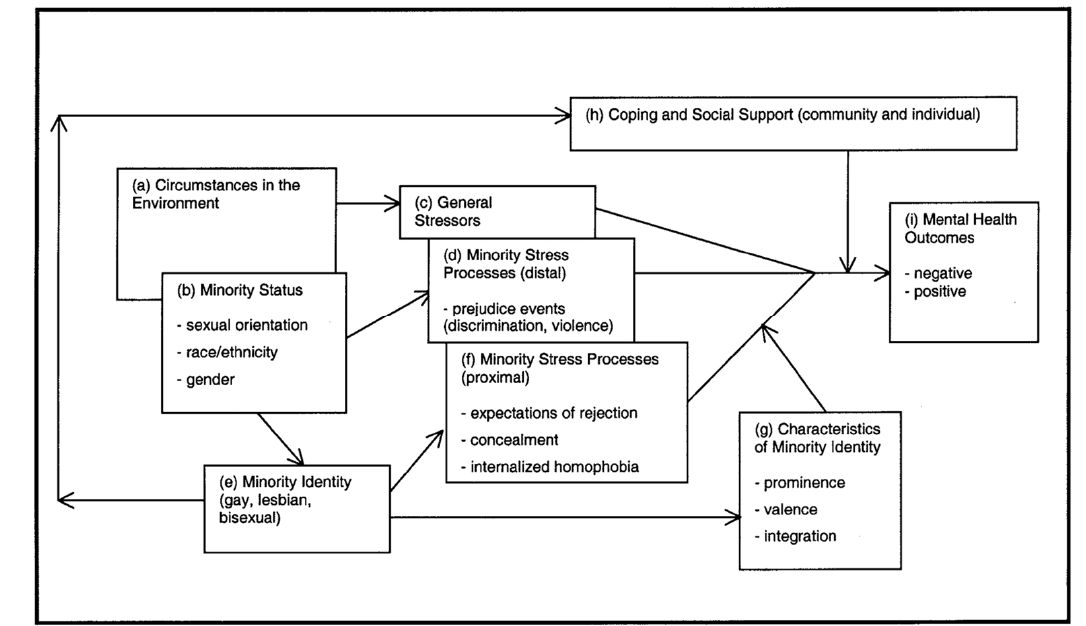
Figure 1. Minority stress model [39].